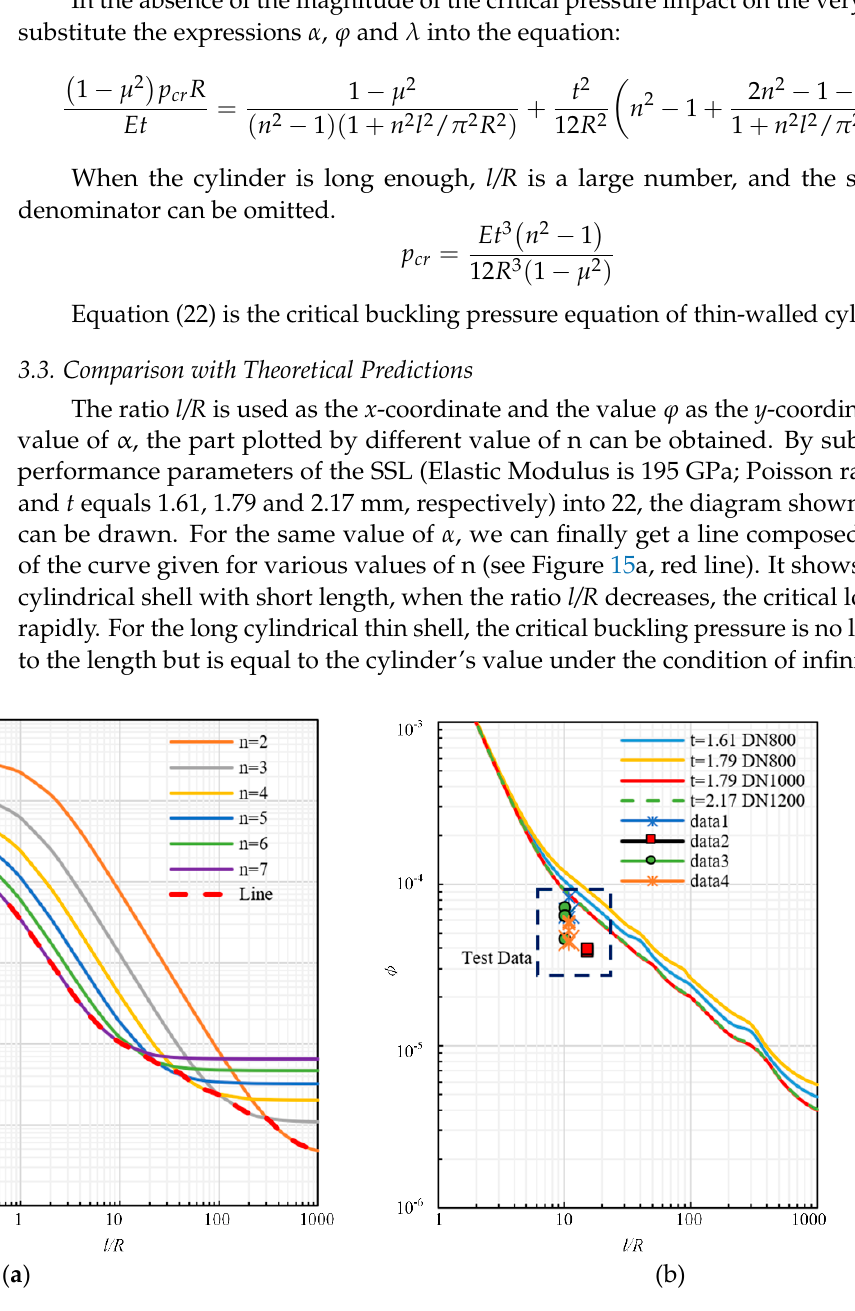
Figure 15. The prediction model of single layer pipeline buckling based on thin-shell theory. ( a ) The buckling model of pipeline under different lobe parameters (T1 data). ( b ) Minimum lobe envelope of different α corresponding to different test groups.